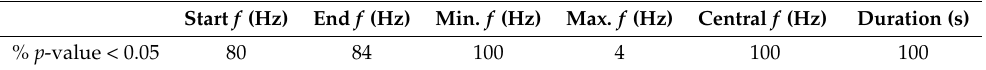
Table 4. Percentages of p -values below the 0.05 significance level for Kruskal–Wallis tests made with 25 different sets of post-detonation